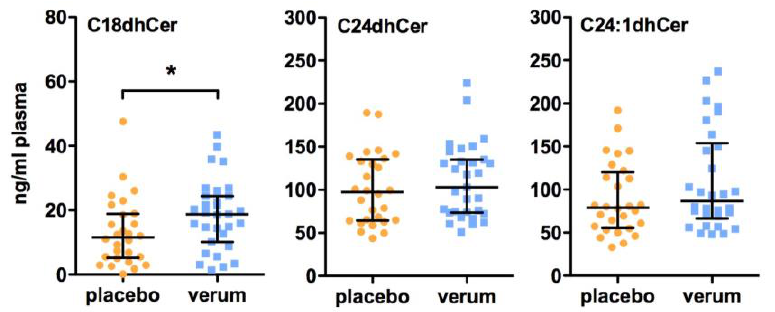
Figure 1. Effect of vitamin D supplementation on plasma dihydroceramide (dhCer) levels. All patients were treated for 6 months with either a placebo or 1904 IU/d vitamin D. Plasma sphingolipid concentrations were measured by LC-MS/MS. Dates are shown as median ± IQR (Mann Whitney U test, * p < 0.05). Abbreviations: dhCer, dihydroceramide.